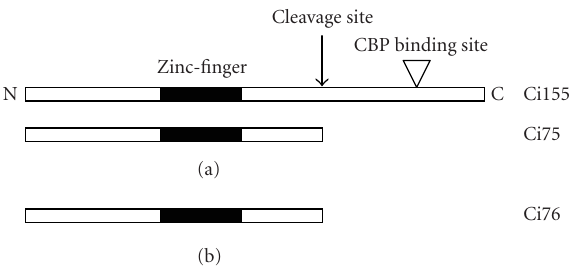
Figure 1. Schematic representation of Ci protein isoforms and upstream activating sequence (UAS) constructs. (a) In vivo forms of Ci. Ci155 and Ci75 are two forms of Ci that are produced during the normal course of development, Ci is a zinc-finger protein homologous to proteins in vertebrate GLI family. Ci75 is normally produced during development by the cleavage of the full-length Ci155 protein at the shown site. cAMP-response-element-binding protein (CREB)-binding pro- tein (CBP)-binding site is located close to the C-terminus. (b) UAS constructs of Ci. Ci76 is the UAS construct used in this in- vestigation to recapitulate the function of the in vivo repressor form of Ci